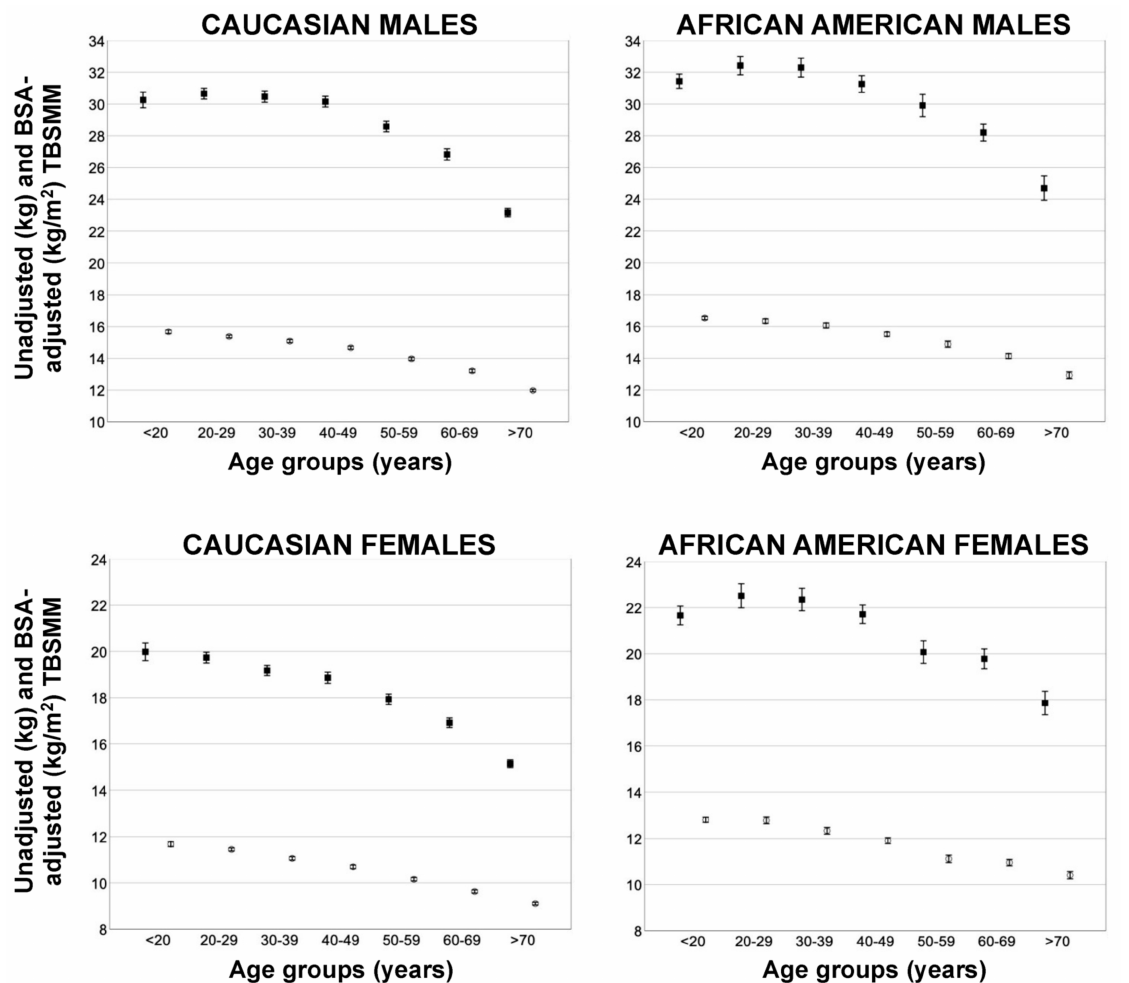
Figure 3. Unadjusted (black squares) and body surface area (BSA)-adjusted (white circles) mean values (obtained with Equation #6) of total body skeletal muscle mass (TBSMM) according to the age group in males (top panels) and females (bottom panels) of the two ethnic groups. Error bars indicate 95% confidence